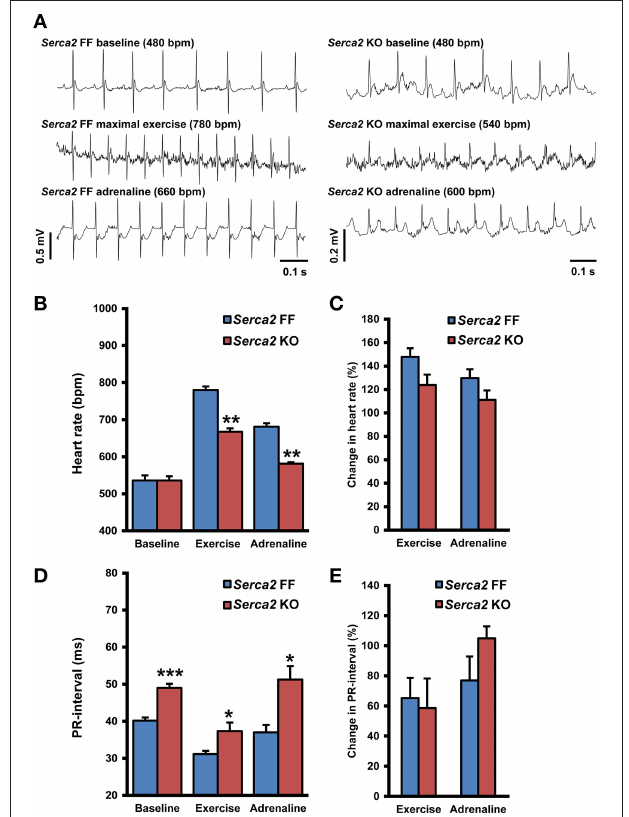
FIGURE 4 | Telemetry ECG parameters. (A) Representative records of telemetry ECG in Serca2 FF (left) and Serca2 KO (right) mice under baseline conditions, maximal exercise, and after a subsequent i.p. injection of adrenaline (0.5mg/kg). (B) Heart rate measurements in freely moving Serca2 FF (blue bars) and Serca2 KO (red bars) mice during baseline conditions, maximal exercise, and after a subsequent i.p. injection of adrenalin (0.5 mg/kg). (C) Change in heart rate during exercise and after adrenaline injection presented as a percentage of corresponding baseline values. (D) The PR-interval in Serca2 FF (blue bars) and Serca2 KO (red bars) mice during baseline conditions, maximal exercise, and after adrenaline administration. (E) Change in PR-interval presented as a percentage of corresponding baseline values. * , ** , and *** denote P < 0.05, P < 0.01, and P < 0.0001, respectively vs. corresponding Serca2